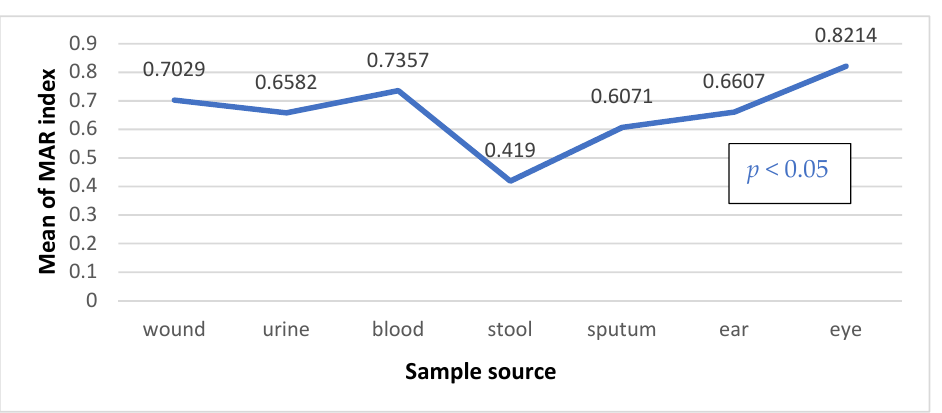
Figure 2. MAR index mean values ( 𝑥̅ ), p value calculated by One-way ANOVA test.